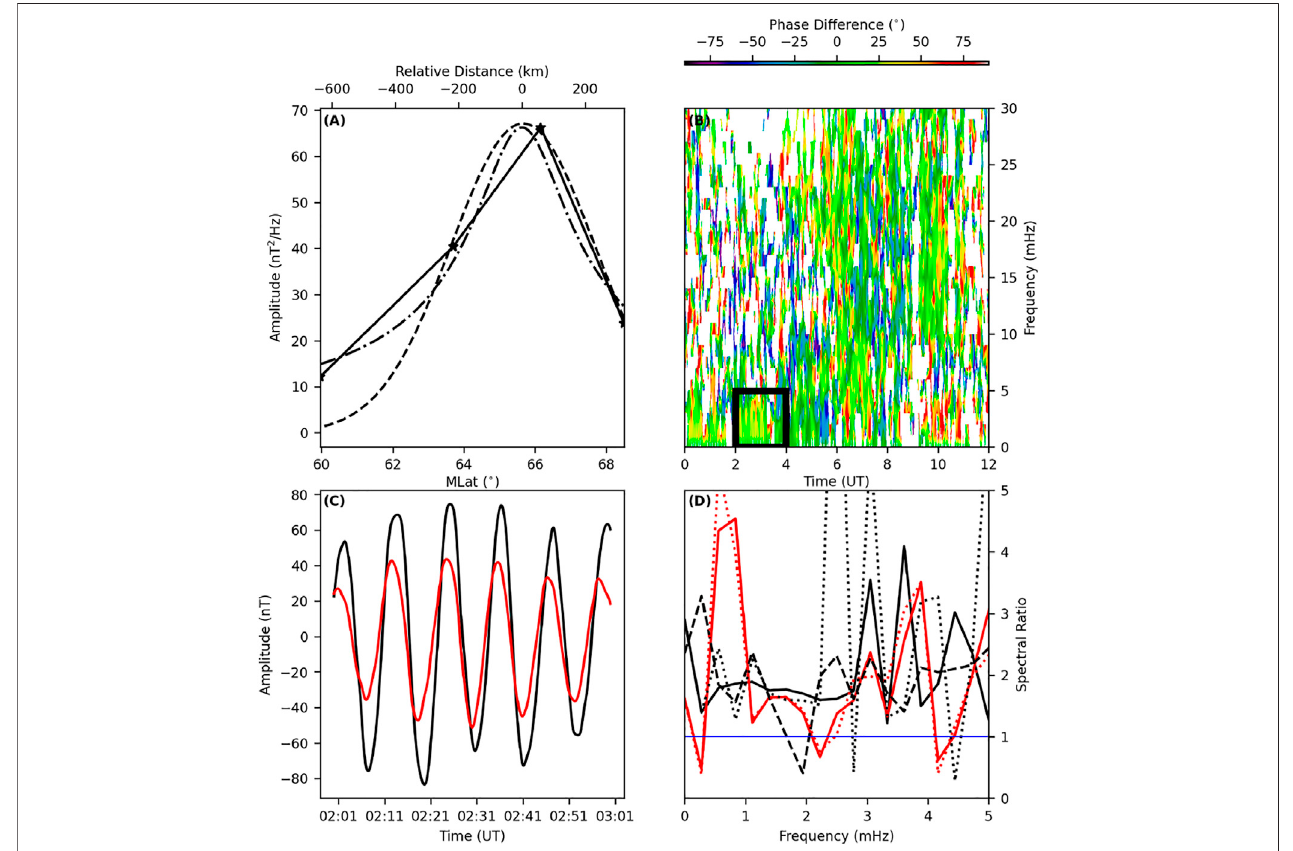
FIGURE 3 | (A) Latitudinal spectral amplitude curve fi ts; Linear piece-wise (solid, stars at station locations), Gaussian (dashed) and FLR amplitude ( Eq. 3 , dash- dotted) versus MLat/km, (B) Dynamic cross phase between FYU-CMO, (C) Time series of the FYU (black) and CMO (red) magnetometer stations, and (D) Spectral amplitude ratio for the boxcar (black, dotted), Hann (red, dashed), Hamming (red, solid), exponential taper (black, solid), and multi-taper (black, dashed) FFT window processing for the FYU-CMO magnetometer data for the 1 October 2012 interval.